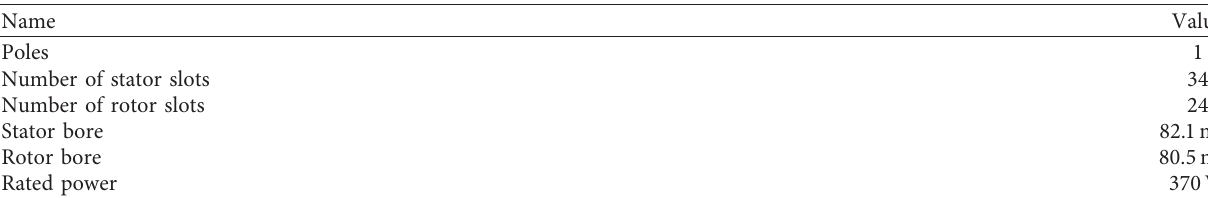
Table 1: Main parameters of